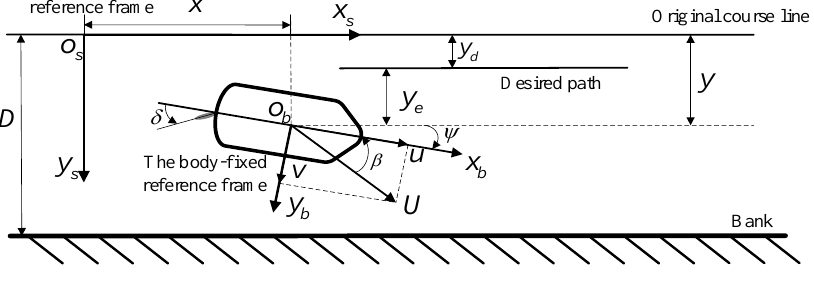
Figure 1. Coordinate systems for a vessel sailing in restricted waters.